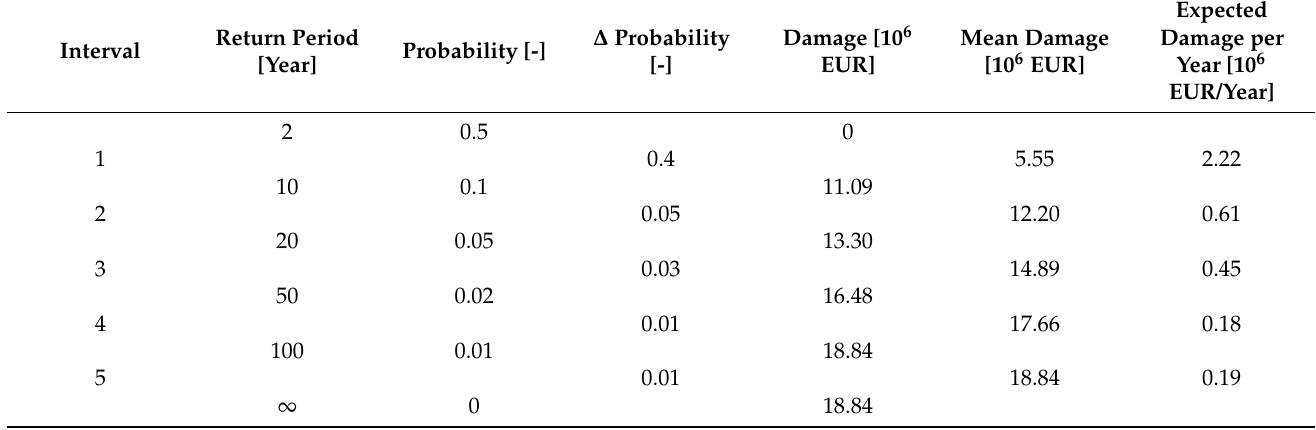
Table A2. Expected annual flood damage calculation matrix for the 0% Meshness